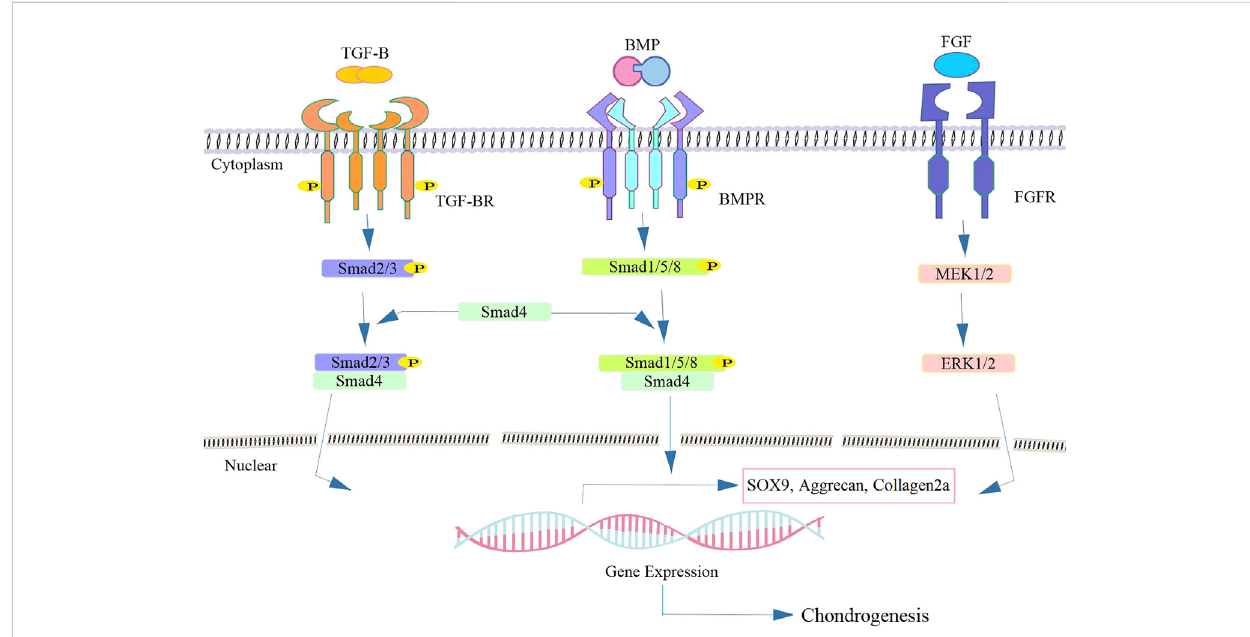
FIGURE 3 SchematicsofrepresentativesignalingbiomoleculespresentinSHED-CMresponsibleforcartilageregeneration.FollowingthebindingoftheTGF- β or BMP ligand to TGF- β -RII, leads to the phosphorylation of TGF- β -RI and subsequent phosphorylation and activation of the intracellular Smad superfamily. The heterocomplex of Smad4 and other co-activators translocate to the nucleus and thereby regulating the target gene expression such as sox9 involved in cartilage regeneration. FGF binds to FGFR and activates the downstream cascade and leading to the expression of the chondrogenic markers via activation of the MEK/ERK signaling